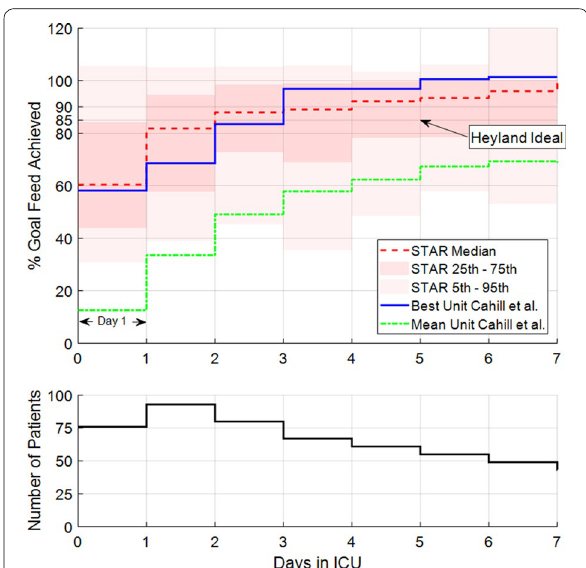
Fig. 2 (Top) Comparison of the median interquartile range of STAR Christchurch’s percentage goal feed achieved clinically ( N Patients) and the best performing unit reviewed in Cahill et al. The ‘Heyland ideal’ 85% caloric goal, to minimise mortality, presented in Heyland et al. [51] is also provided for comparison. (Bottom) The number of patients per day, where it is important to note that not all of the 221 patients start on day 1